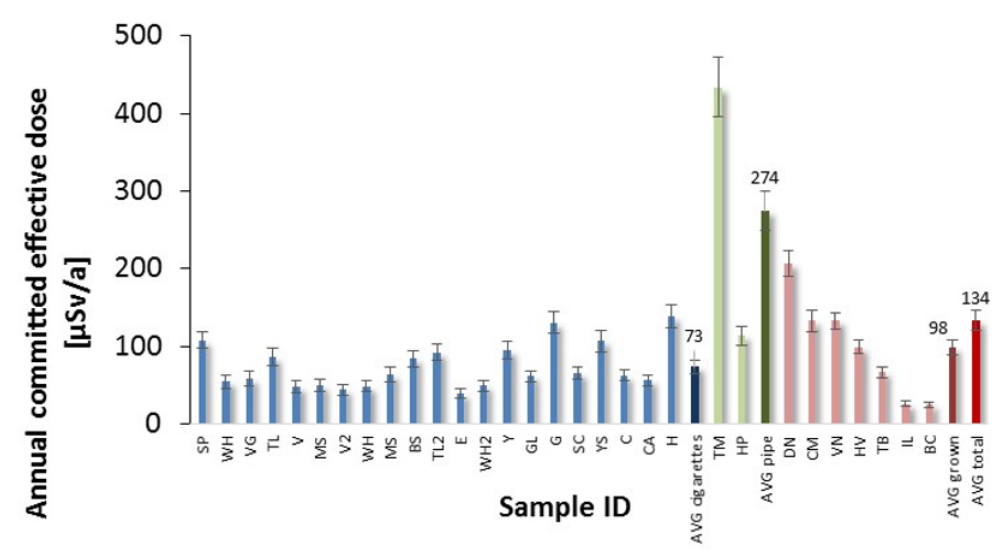
Figure 4. Annual committed effective dose contribution of the investigated Vietnamese tobacco